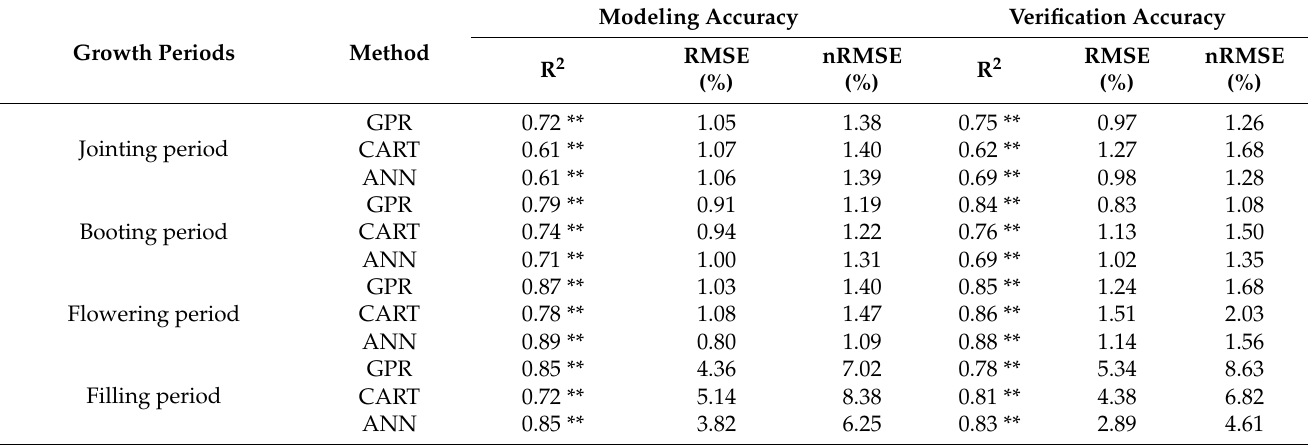
Table 2. The LWC estimation results obtained by adopting differential spectra combined with GPR, CART, and ANN for different growth